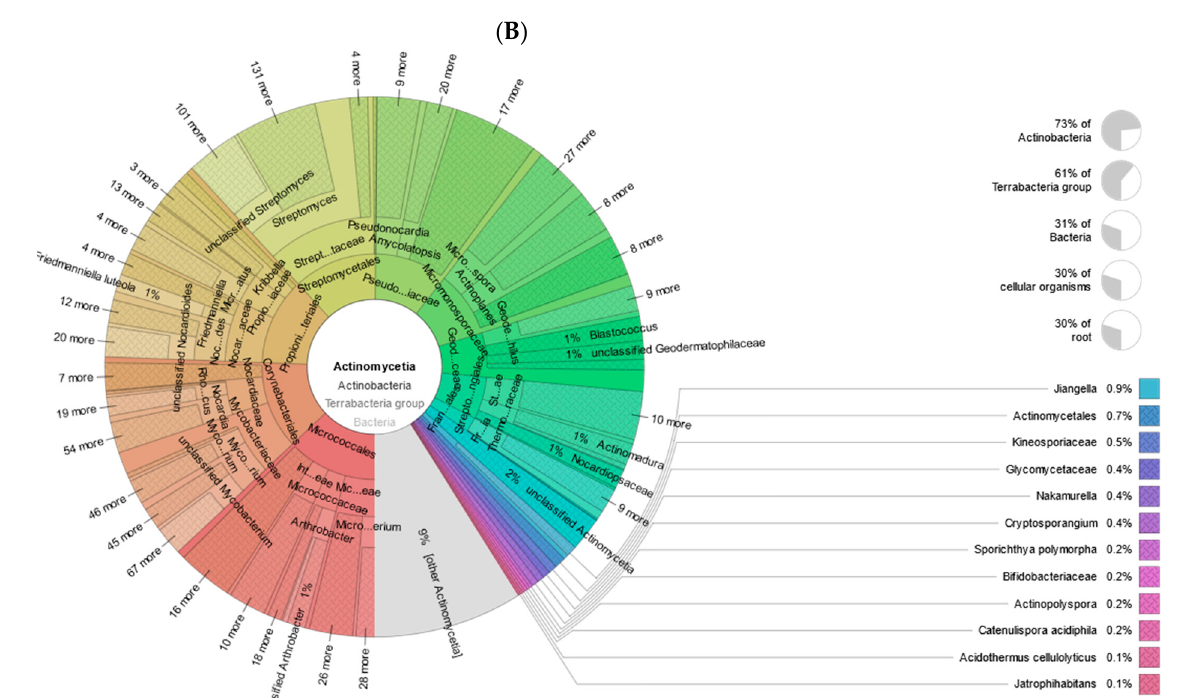
Figure 5. Krona plots of Actinomycetia detected in metagenomic datasets. ( A ) non-polluted, ( B ) polluted soil. Note: Taxonomic nodes are nested sectors arranged from the highest level of the hierarchy at the center and progressing outward. Krona plots simultaneously display relative abundance and hierarchy using a radial space-filling display. Taxonomic groups are separated by color.